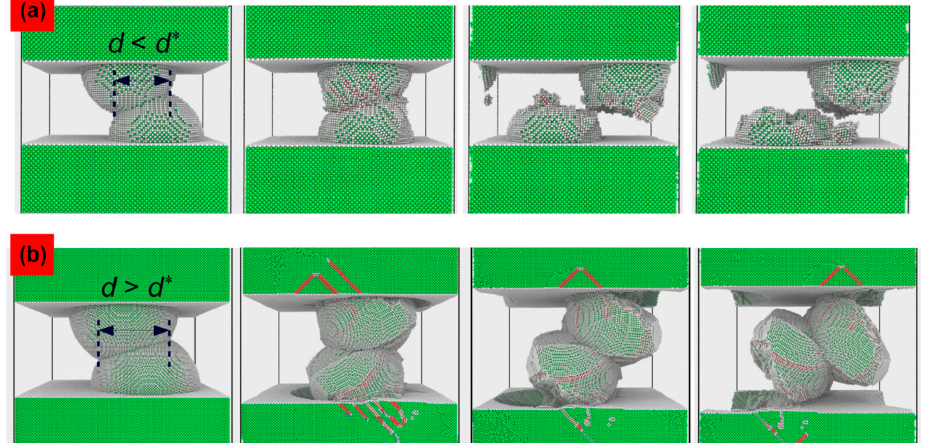
Figure 3. Two adhesive wear mechanisms at the asperity level revealed by atomic simulations, taken from [16]: ( a ) the plastic smoothing mechanism in the absence of a wear debris particle; ( b ) the fracture-induced particle formation mechanism.